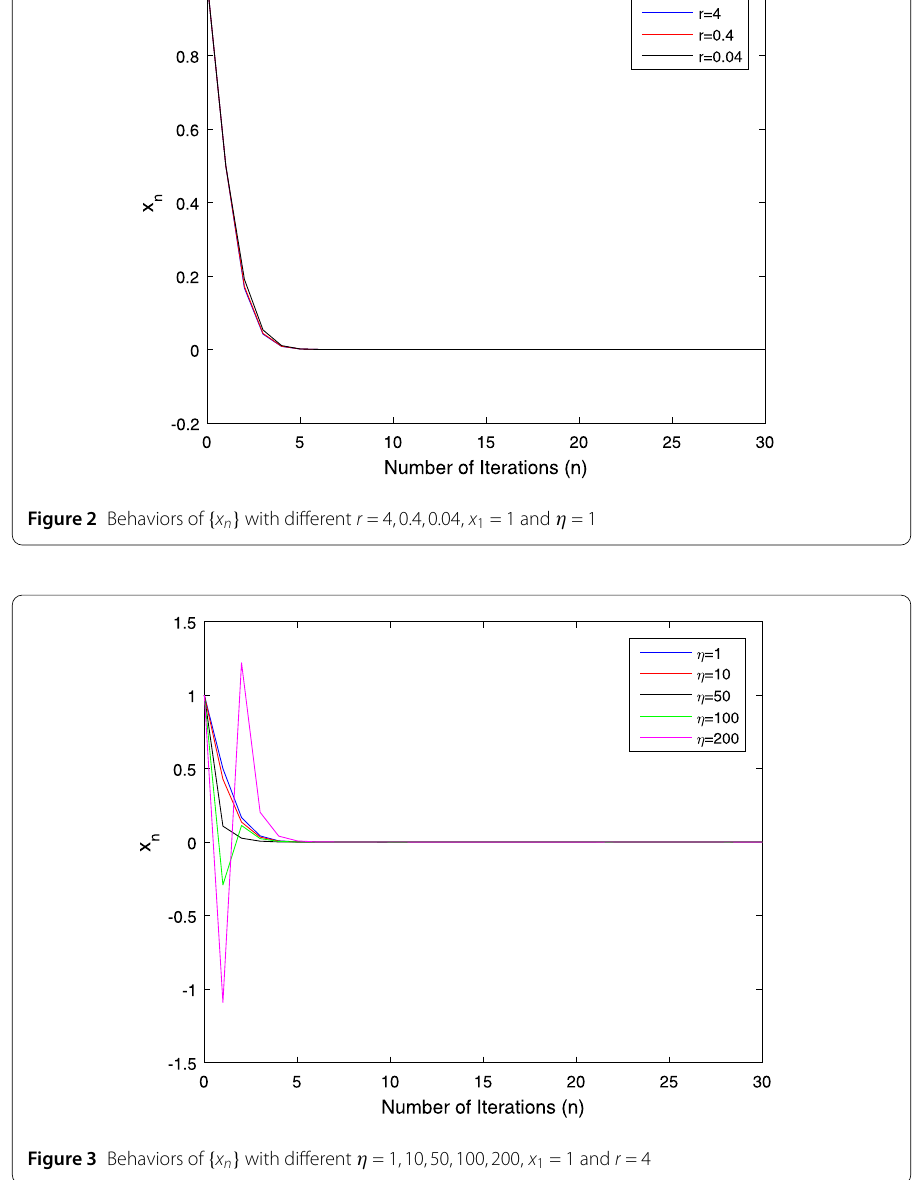
Case 2. Taking the different r = 4,0.4,0.04 with x 1 = 1, η = 1, Fig. 2 presents the conver- gence behaviors of { x n } for Algorithm